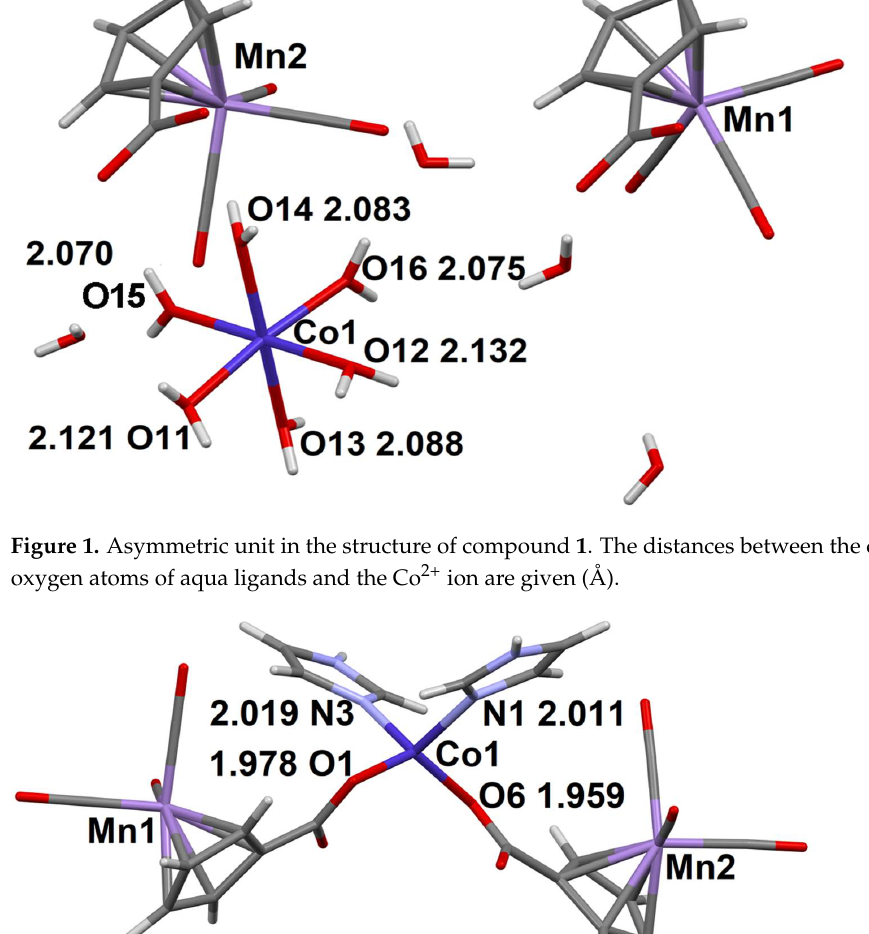
Figure 2. The structure of complex molecule in compound 4 . The distances between the coordinating atoms of the ligands and the Co 2+ ion are given (Å).